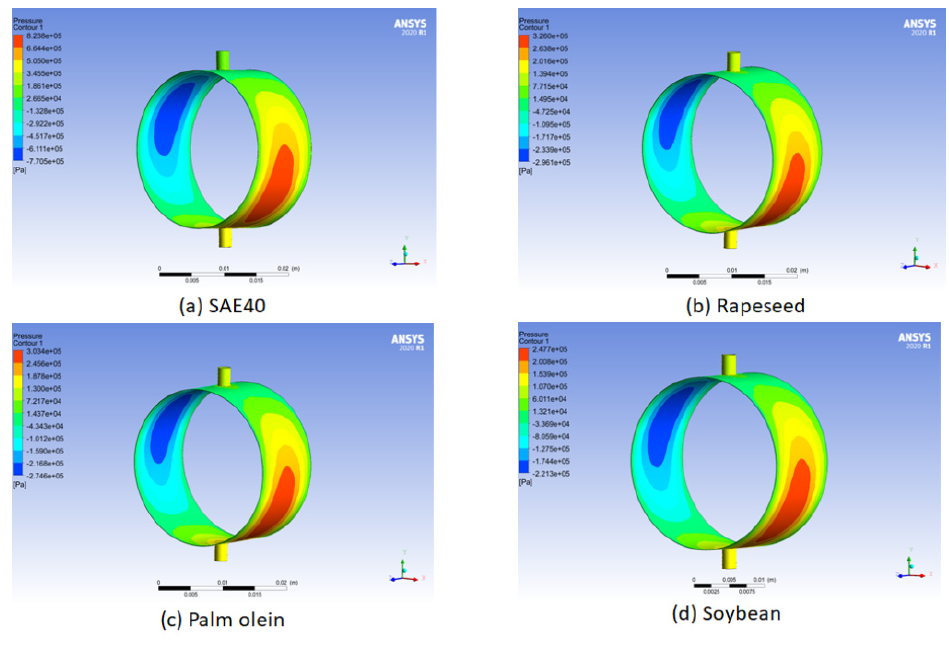
Figure 8. Hydrodynamic pressure distribution.